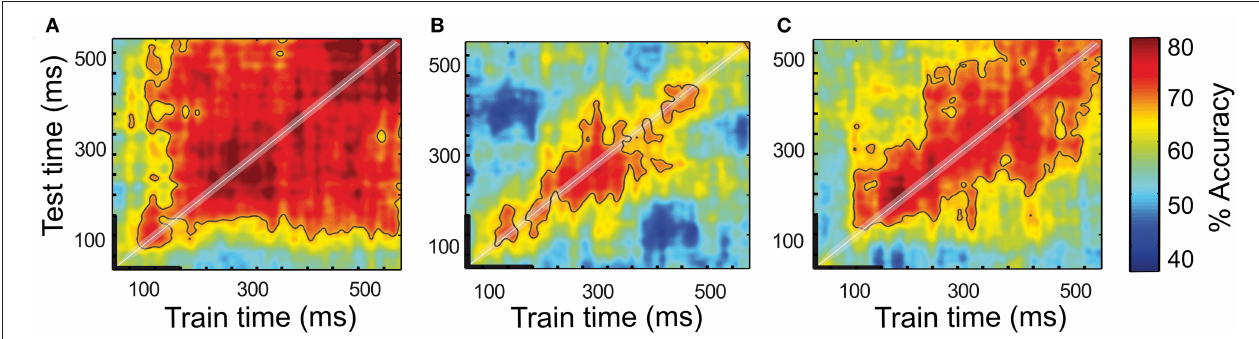
FIGURE 2 | Temporal dynamics of a spatial attention signal. Full cross-temporal classification analysis of the attention-specific FEF population (A) , entire LIP population (B) , and entire FEF population (C) . Classifiers are trained to classify spatial attention from the population activities at every time step within 600ms following a cue onset and prior to a target onset ( x -axis, thick black line corresponds to the cue presentation). The performance of each classifier is tested from the population activities obtained from naïve trials at every time step within the same time period relative to the cue. Red colors represent high performance whereas the blue-colored regions represent low performance [chance level at 50%, figure adapted from Astrand et al.